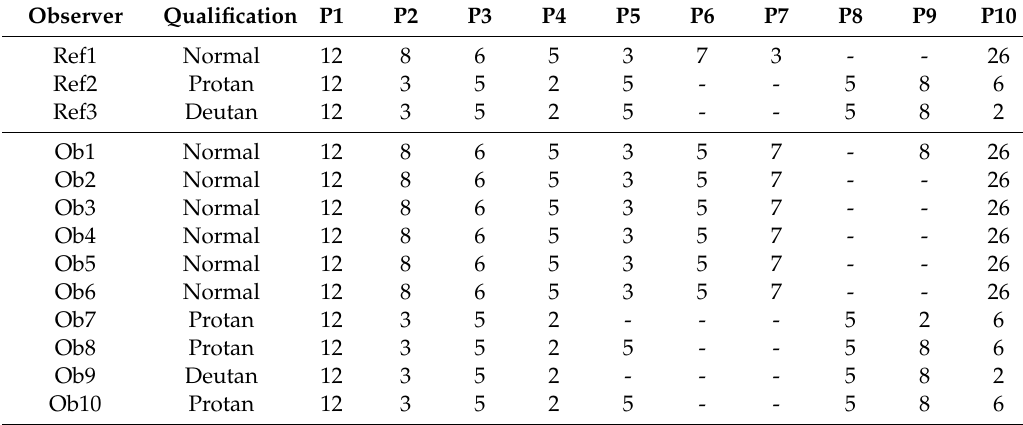
Table 6. Numerical responses of the 10 real observers to the 10 plate virtual version of the Ishihara Test. Observer Qualification P1 P2 P3 P4